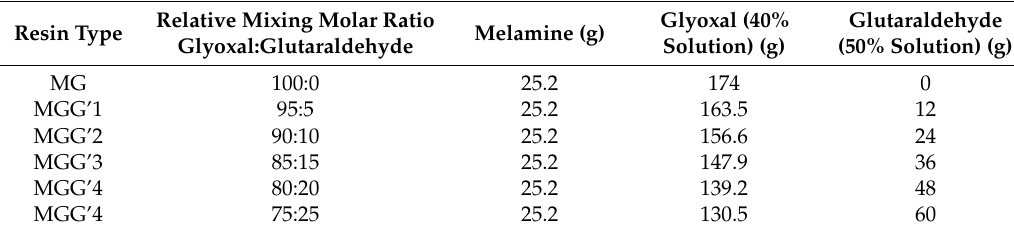
Table 1. Proportions of melamine (M), glyoxal (G) and glutaraldehyde (G’) used in the preparation of the MGG’ resins.